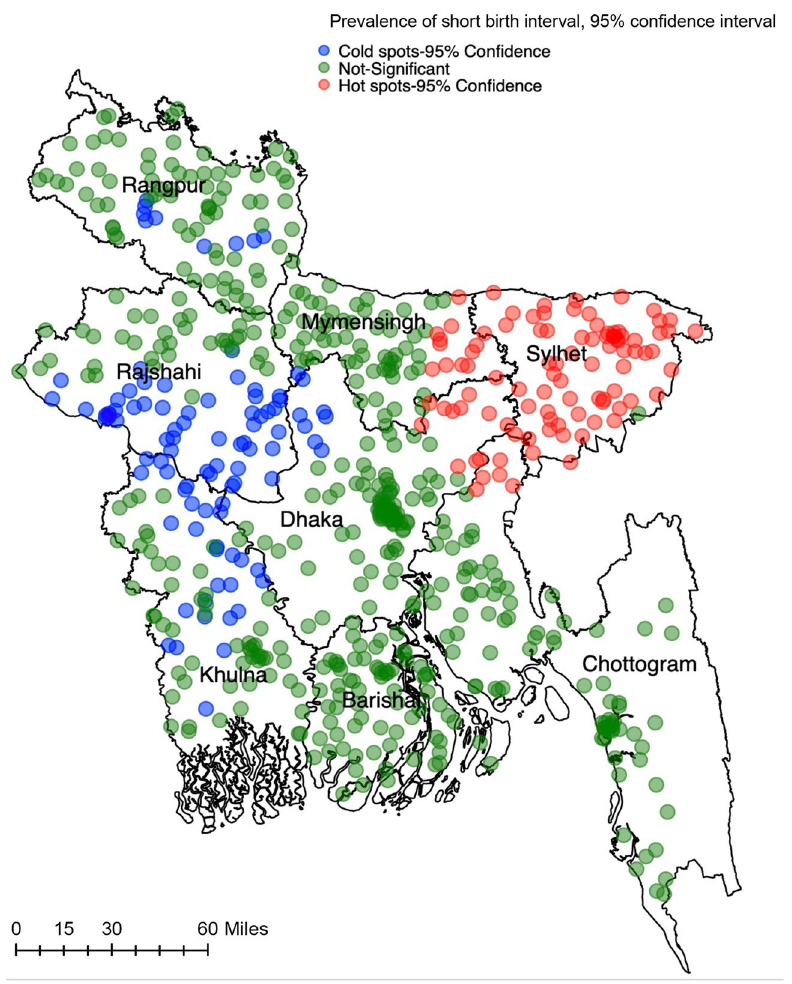
Figure 2. Hot spots and cold spots of short birth intervals in Bangladesh. Map created using ArcGIS version 10.6.1 (ESRI. ArcGIS Desktop: Release 10. Redlands, CA: Environmental Systems Research Institute,